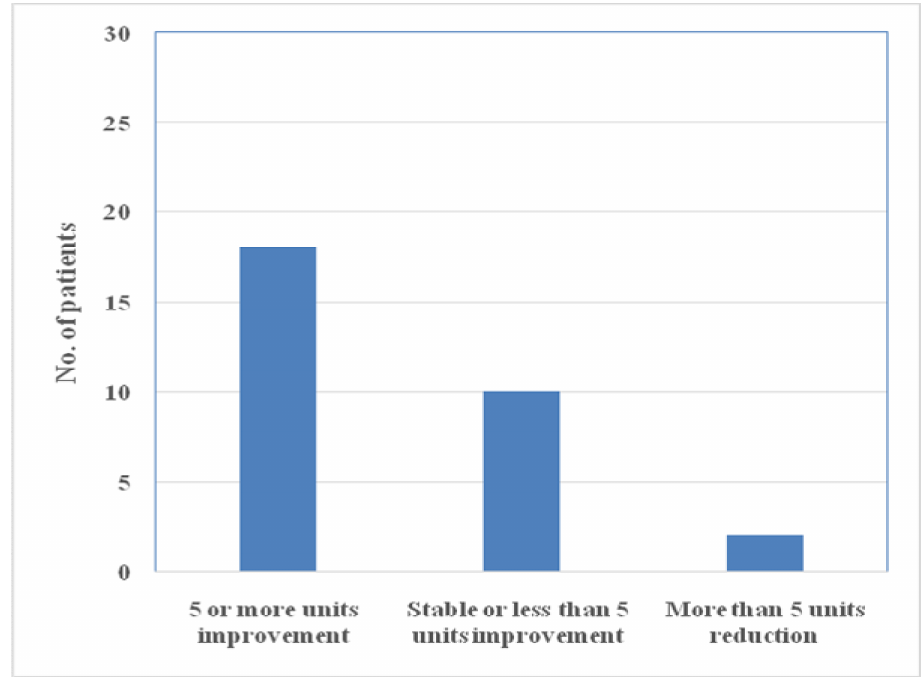
Figure 1. Change in National Eye Institute Visual Function Questionnaire 25 (NEI-VFQ-25) composite scores.